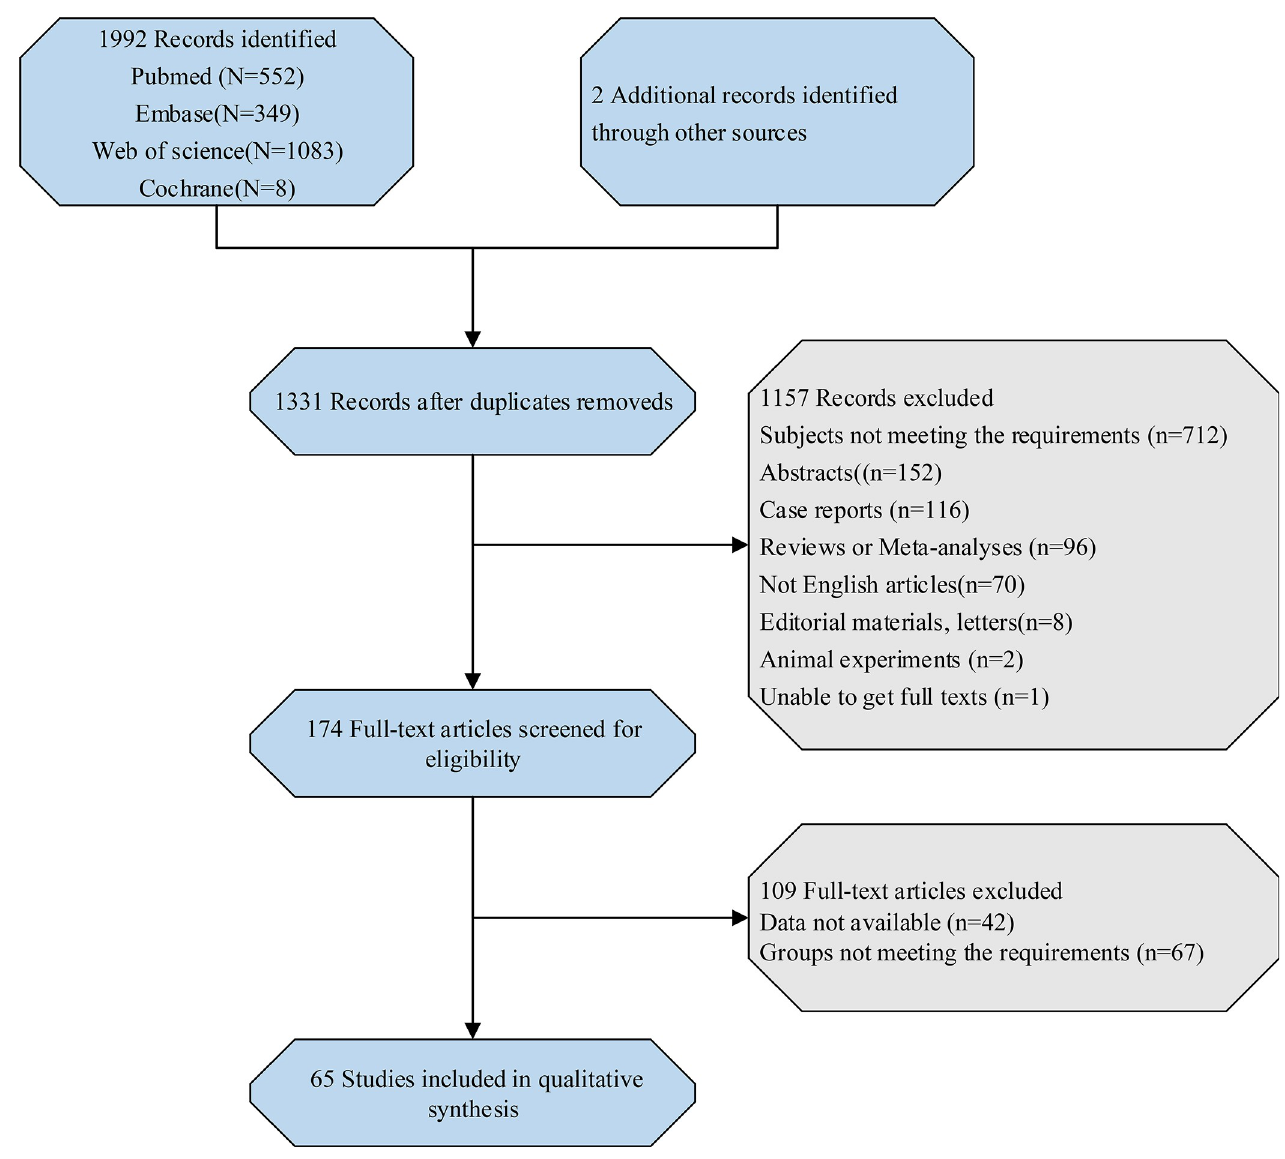
Fig 1. Flow chart of the study selection process. Lateral lymph node metastasis. A total of 11 studies consisting of 1362 patients provided data to assess lateral lymph node metastasis. The heterogeneity test results were not statistically significant (I 2 = 43.3%), so the fixed-effect model was adopted. It was shown that HT was asso- ciated with a decreasing risk of lateral lymph node metastasis in PTC patients (OR: 0.845, 95% CI: 0.733–0.973, P = 0.02) (Table 2, Fig 2C). Distant metastasis Distant metastasis was assessed in 11 studies comprising 151 patients. The fixed-effects model result showed that the HT group was at a lower risk of distant metastasis than the non-HT group (OR: 0.435, 95%CI: 0.279–0.676, P < 0.001) (Table 2, Fig 3).